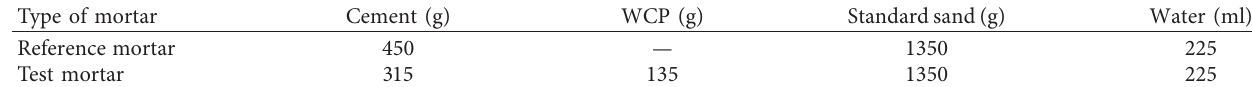
Table 1: Mixture ratio of